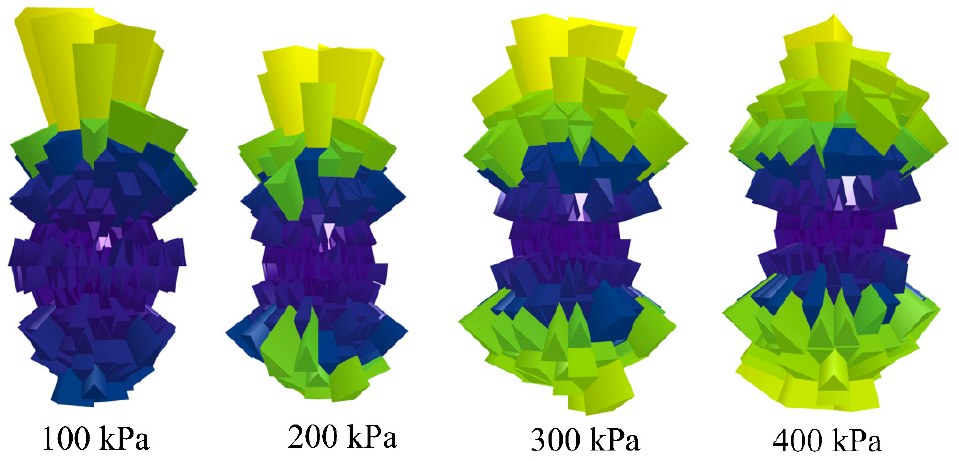
Figure 11. Stress vector spatial statistical graph of remolded soils.